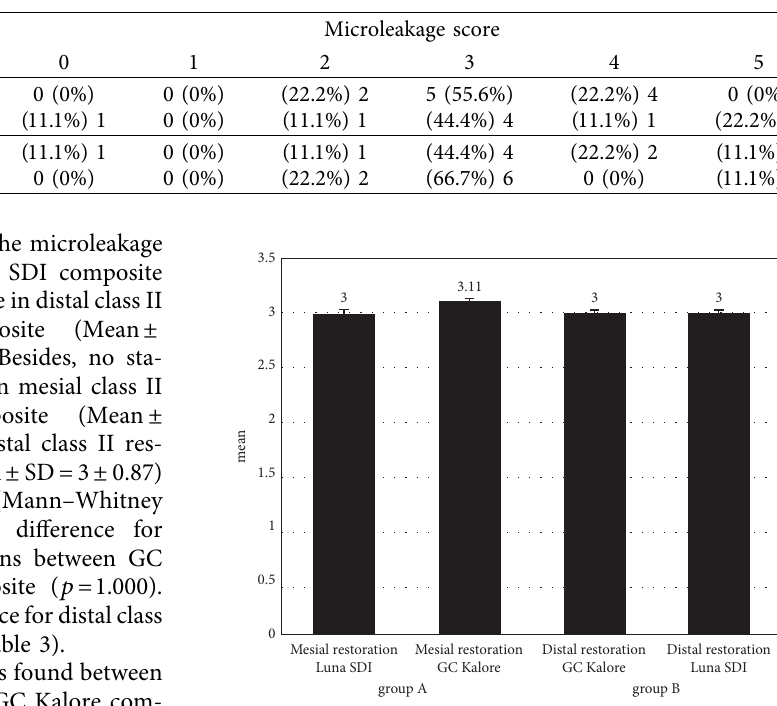
Figure 1: Te comparison of the microleakage of each composite between mesial and distal class II restorations regarding their group. Table 3: Mean and standard deviation of microleakage of two composites (Luna SDI and GC Kalore) based on mesial and distal.